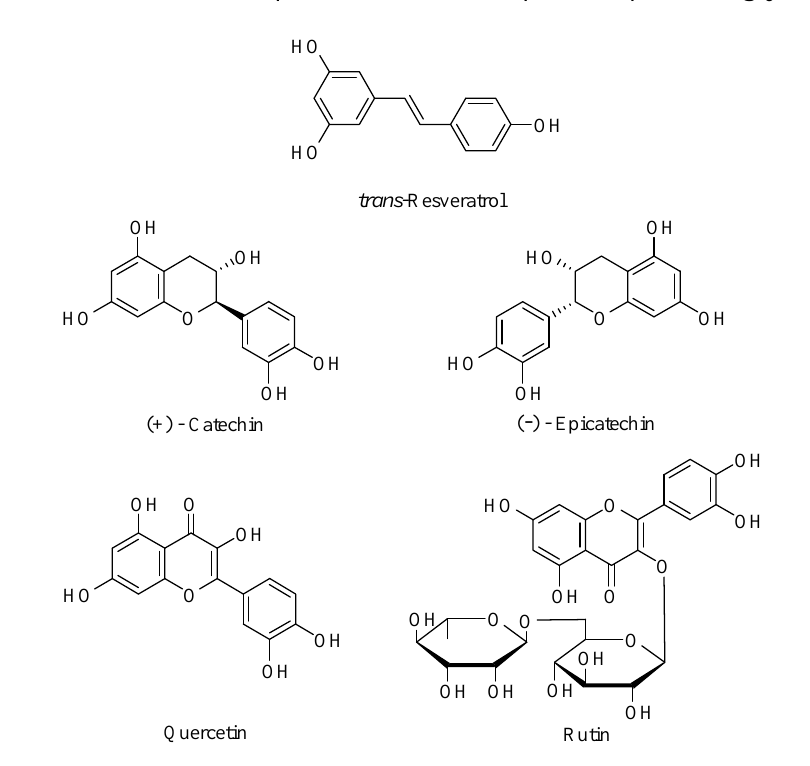
Figure 1. Chemical structures of (+)-catechin, ( − )-epicatechin, trans- resveratrol and quercetin. The structure of rutin is provided as an example of a